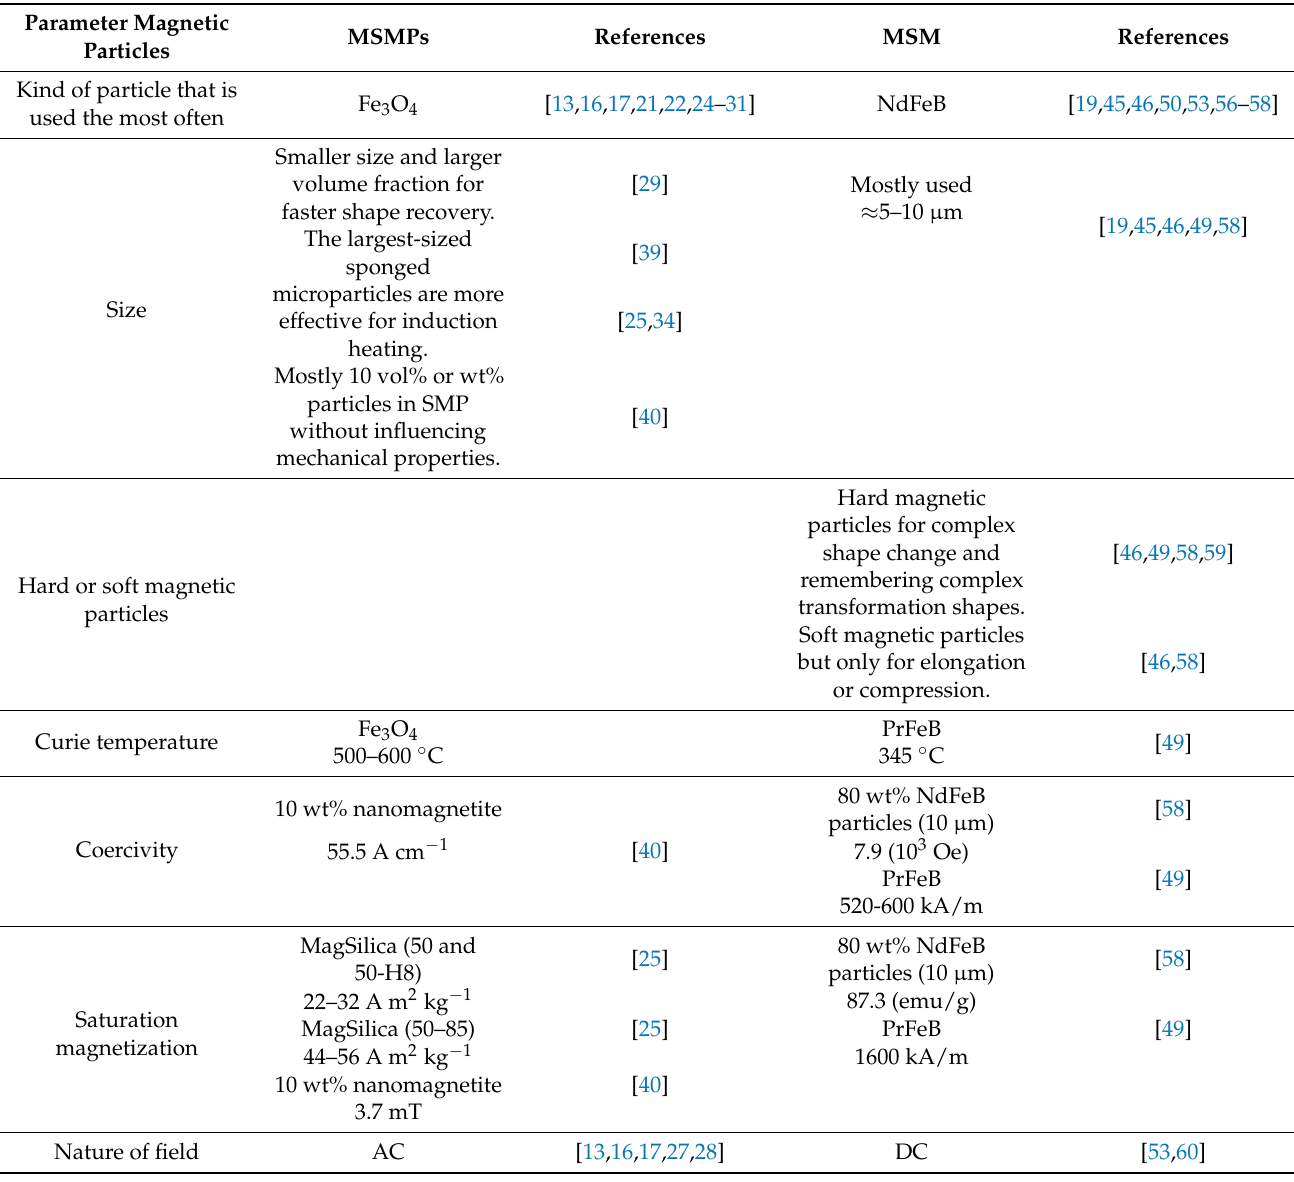
Table 1. Summarized performance metrics of the magnetic